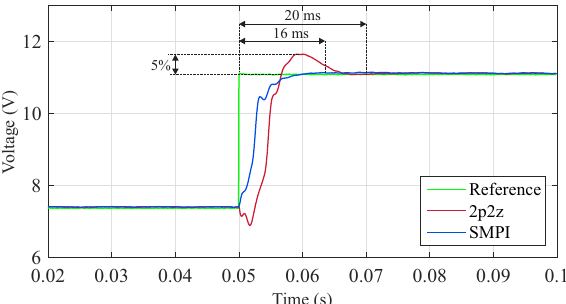
Figure 12. Comparison of the SMPI and two-pole two-zero controller (2p2z) controllers for a voltage step test.